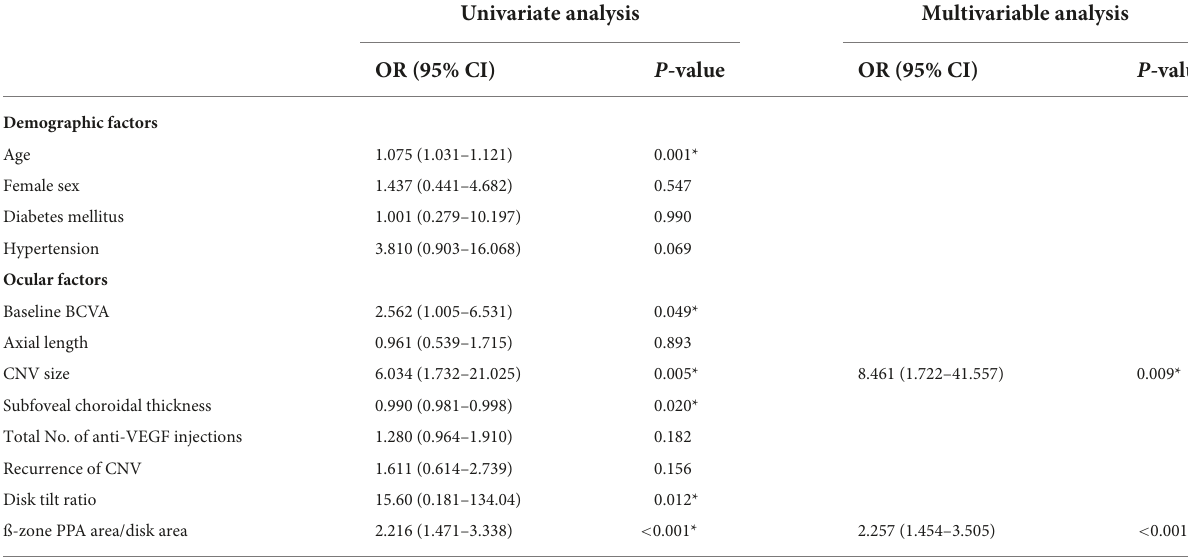
TABLE 4 Baseline characteristics associated with the occurrence of macular atrophy in eyes with myopic choroidal neovascularization. Univariate analysis